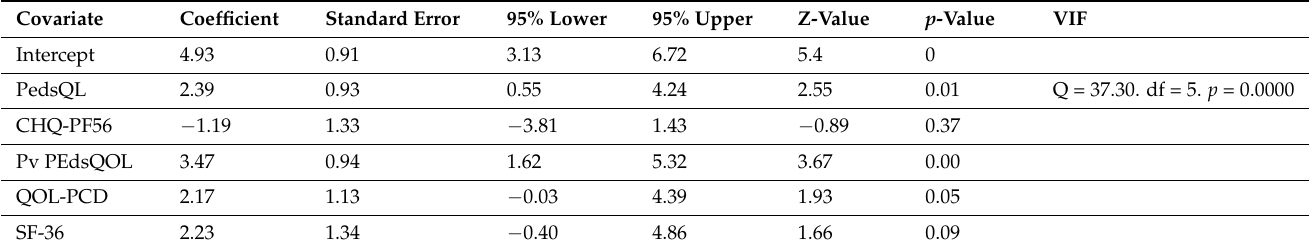
Table 3. Meta-regression by instrument.